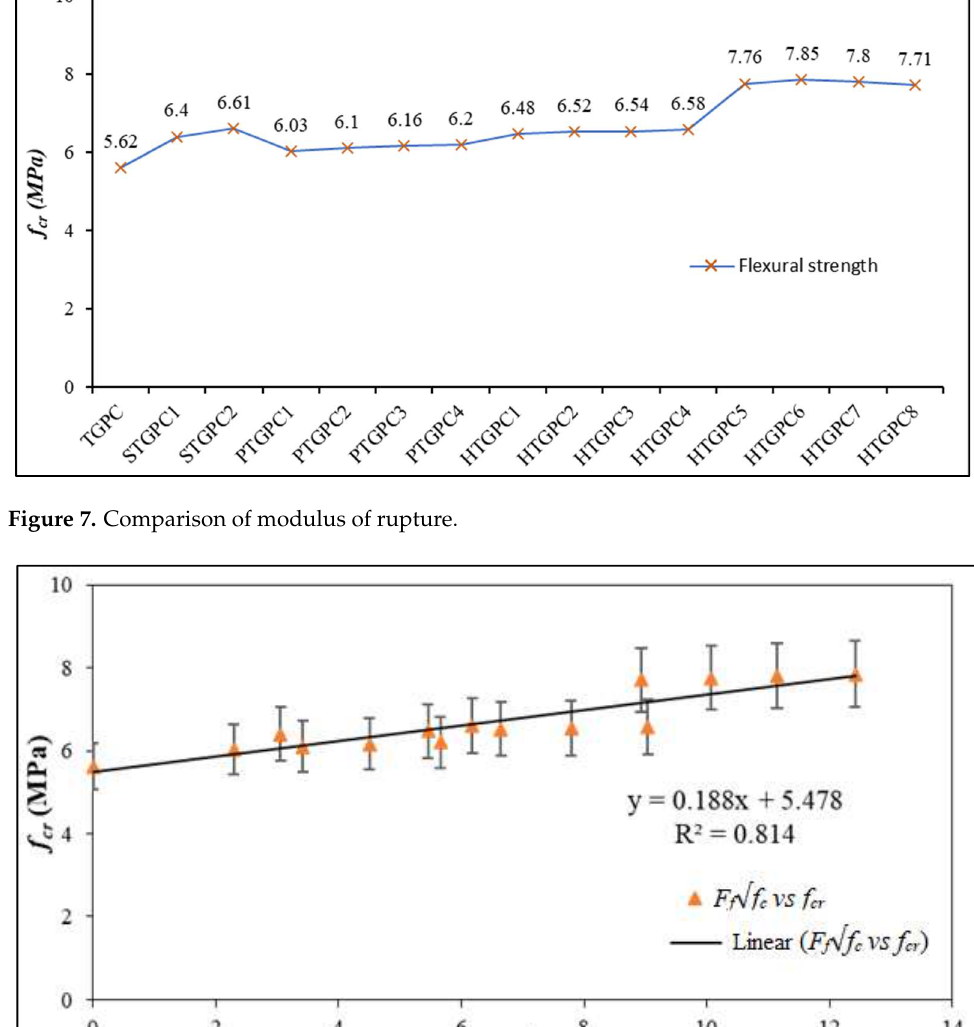
Figure 8. Relationship between f cr and F f √ f c